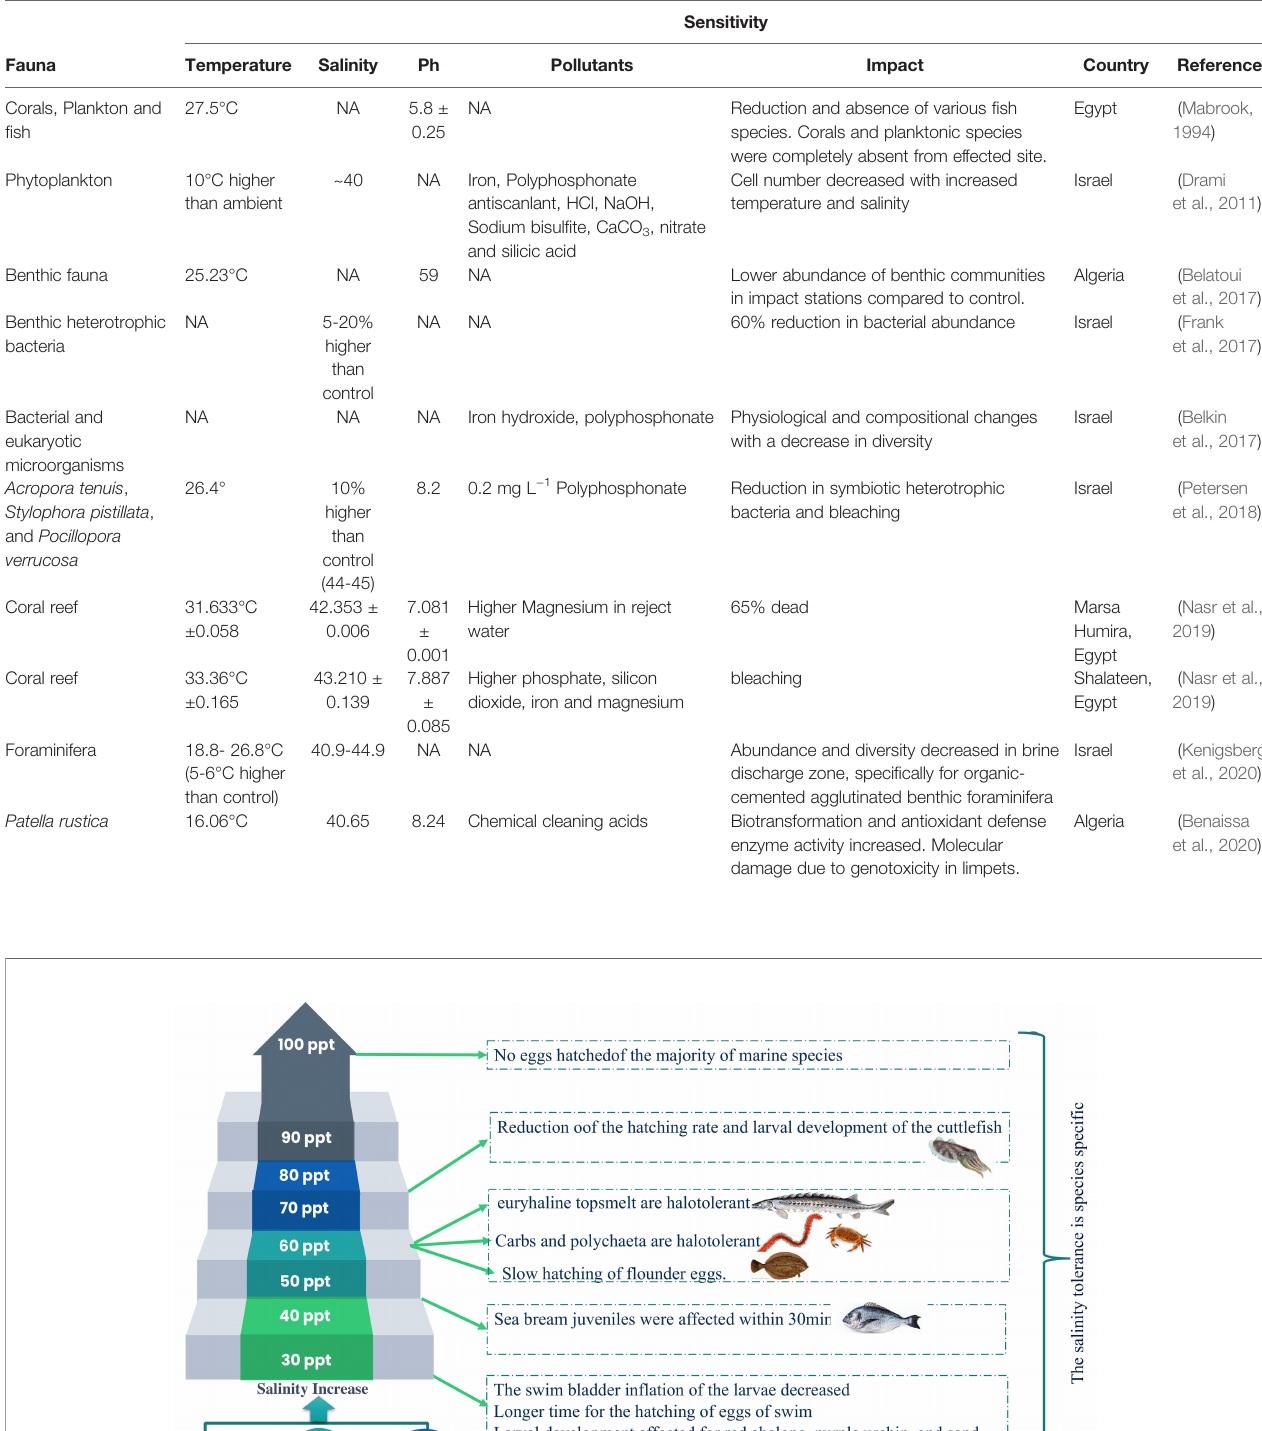
TABLE 2 | Impact of the Desalination Brine on the Marine Health.